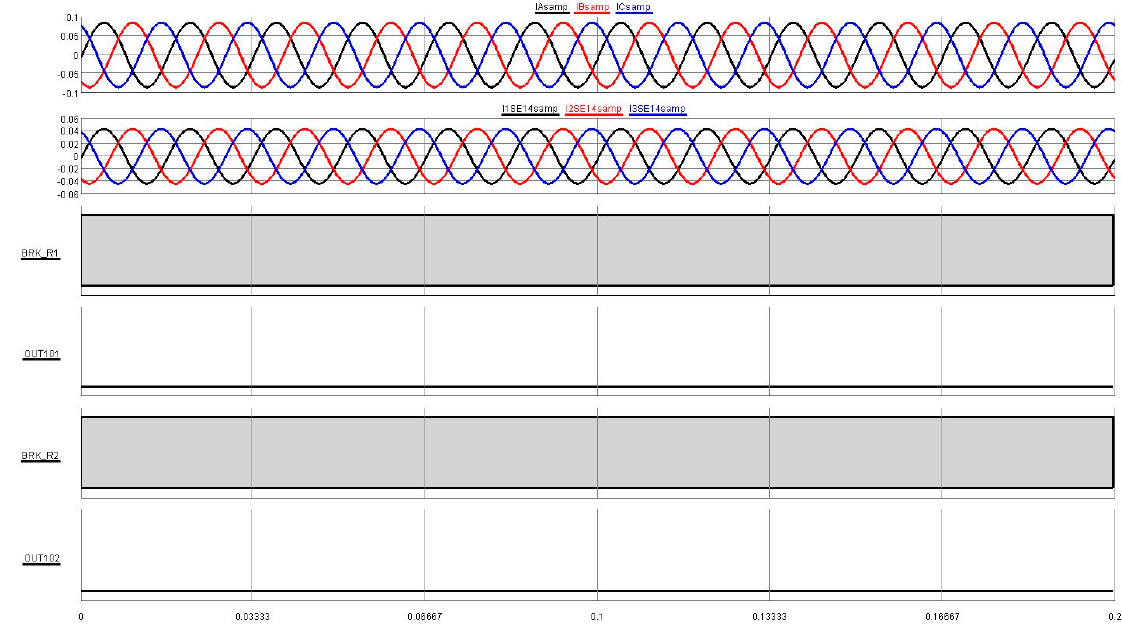
Figure 20. Circuit breaker logic for relay R1.